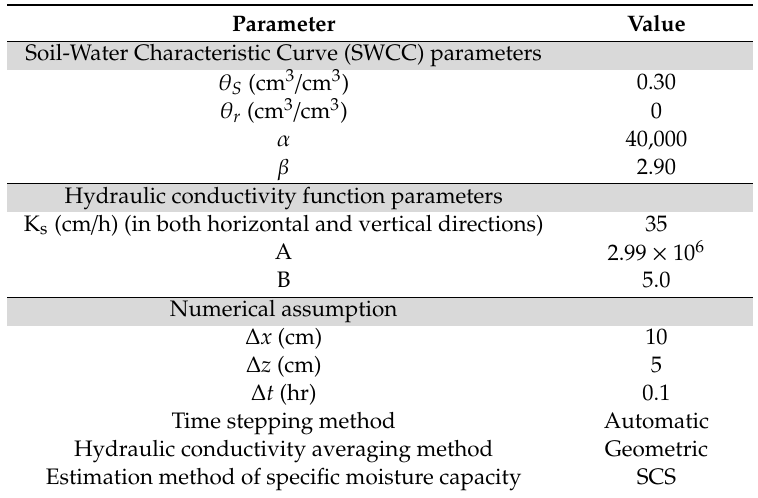
Table 6. Summary of parameters used in the water table recharge problem